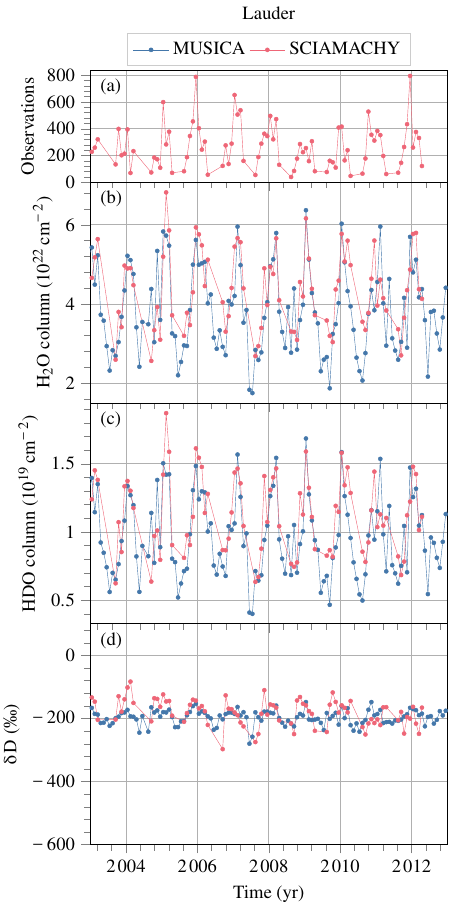
Figure 6. Same as Fig. 3, but for the station